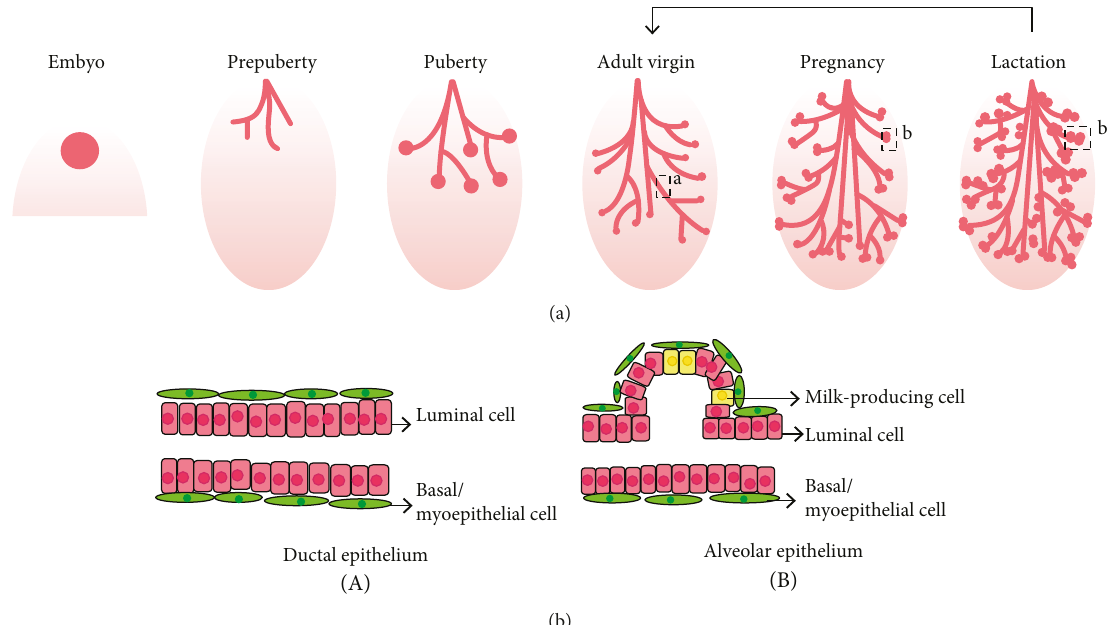
Figure 1: (a) The postnatal mammary gland development is multistage. (b) Two distinct phenotypes of mammary epithelium in di ff erent developmental stages: the ductal (A) and alveolar (B) epithelium, both bilayered, with inner layer of luminal cells and outer layer of myoepithelial/basal cells. There are also milk-producing cells in the inner layer of alveolar